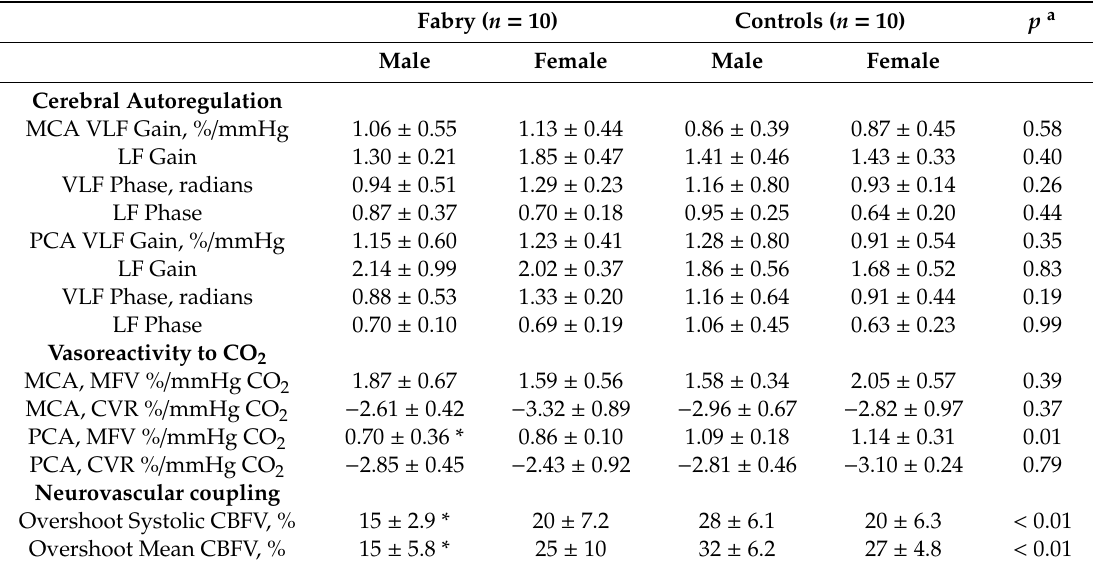
CBFV: cerebral blood flow velocity; Hz: hertz; VLF / LF: very-low (0.02–0.05 Hz) and low frequency (0.05–0.2 Hz) bands; MCA: middle cerebral artery; MFV: mean flow velocity; PCA: posterior cerebral artery. All values are in means ± SD. a p value of repeated-measures ANOVA for the interaction between group variable (Fabry vs. heathy controls), sex, and arterial territory (MCA vs. PCA) with significant di ff erences after Bonferroni corrections marked with asterisk (*).